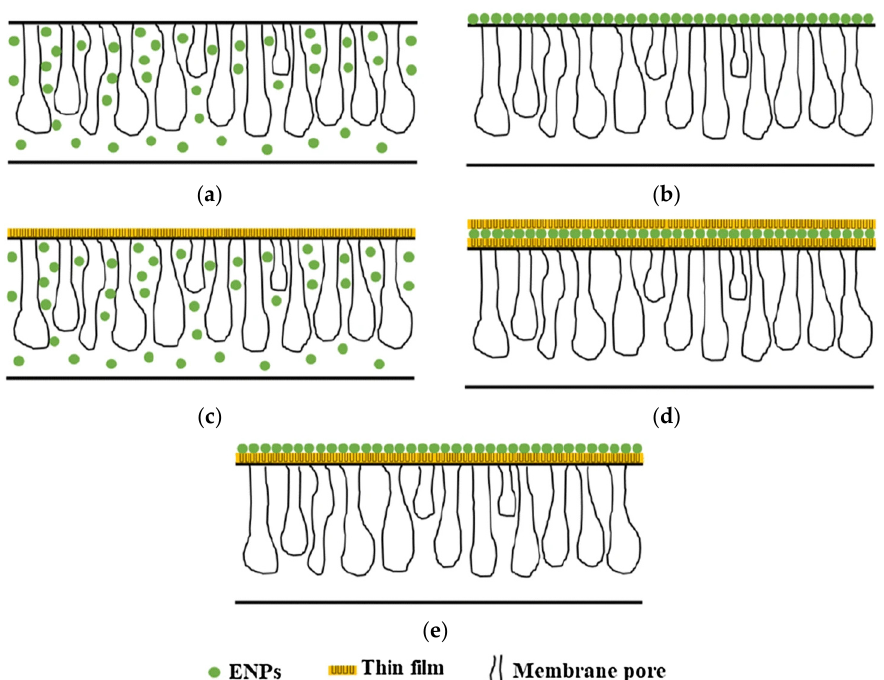
Figure 5. Design of nanocomposite membrane. ( a ) conventional nanocomposite, ( b ) surface coated membrane, ( c ) TFC with nanocomposite substrate, ( d ) thin film nanocomposite, ( e ) surface coated TFC. Reprinted from [81] with permission from Springer Nature, 2019.